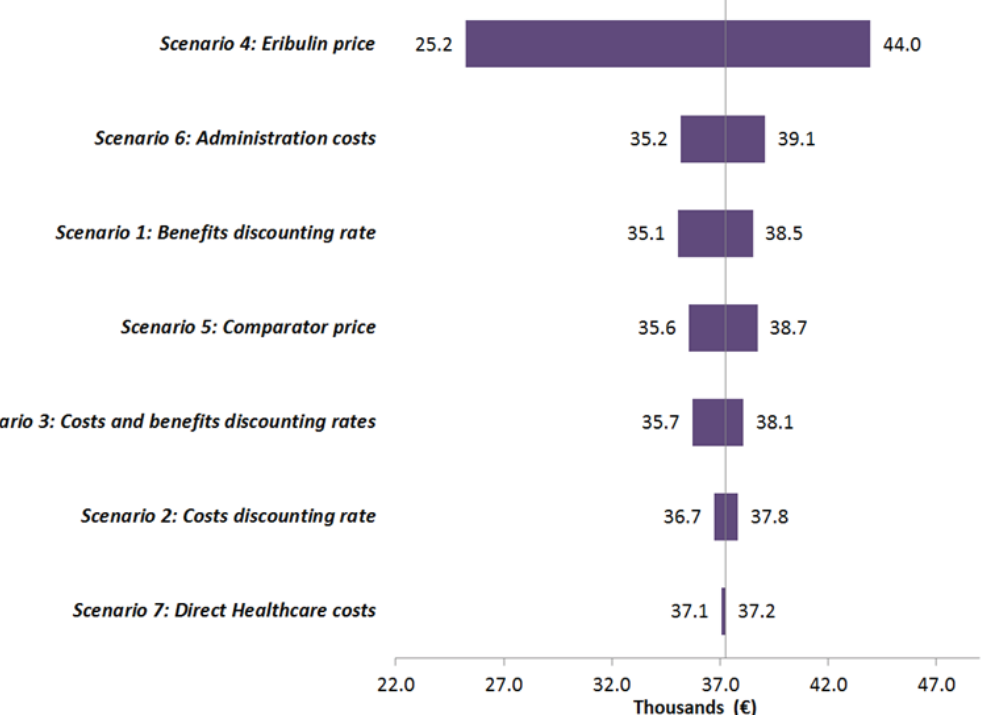
Figure 2. Tornado Graph of Deterministic Sensitivity Analysis Results (ICER per QALY) for HER2-Negative Patients receiving Second-line Therapy